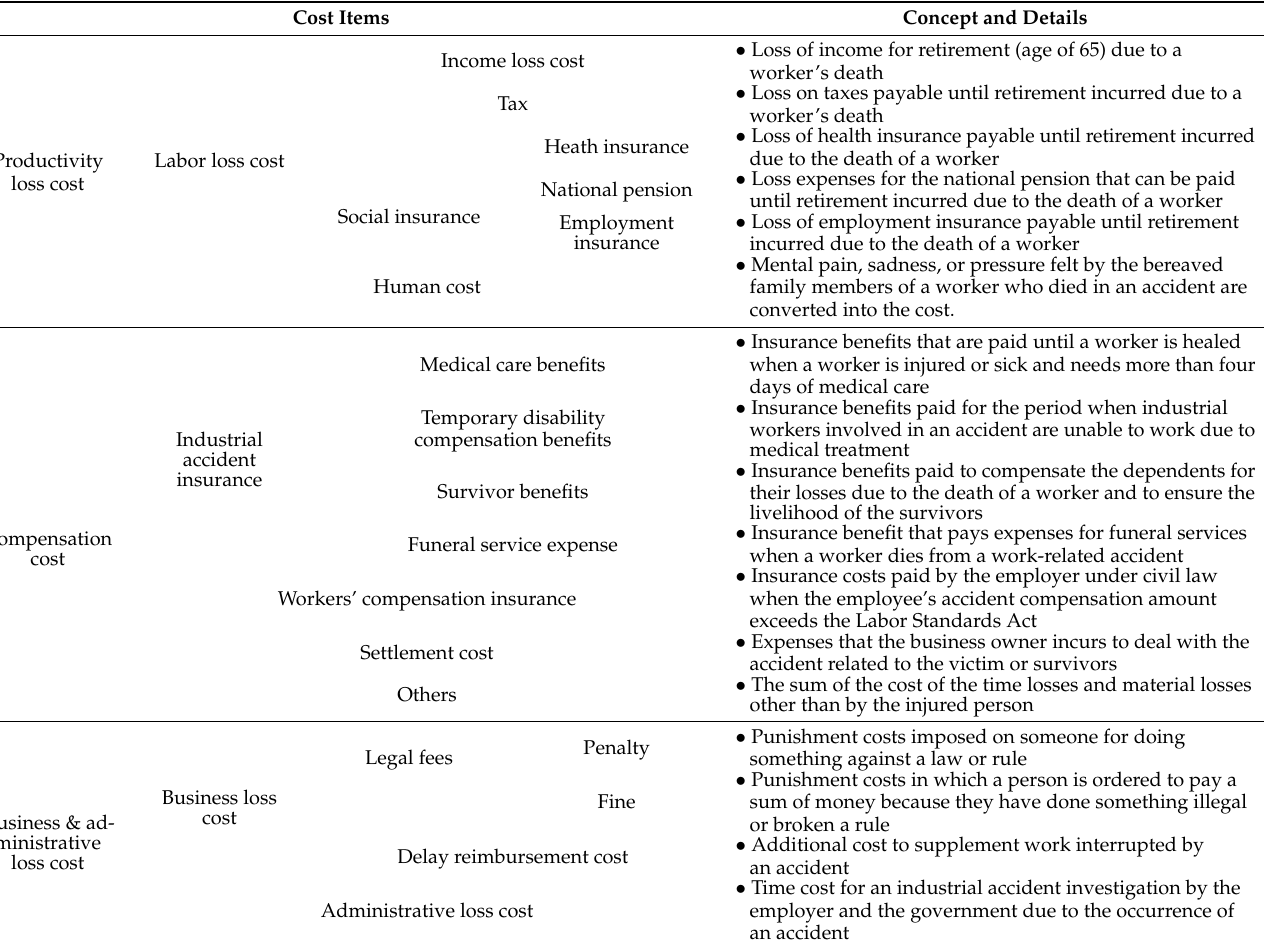
Table 6. Results of framework development on fatality